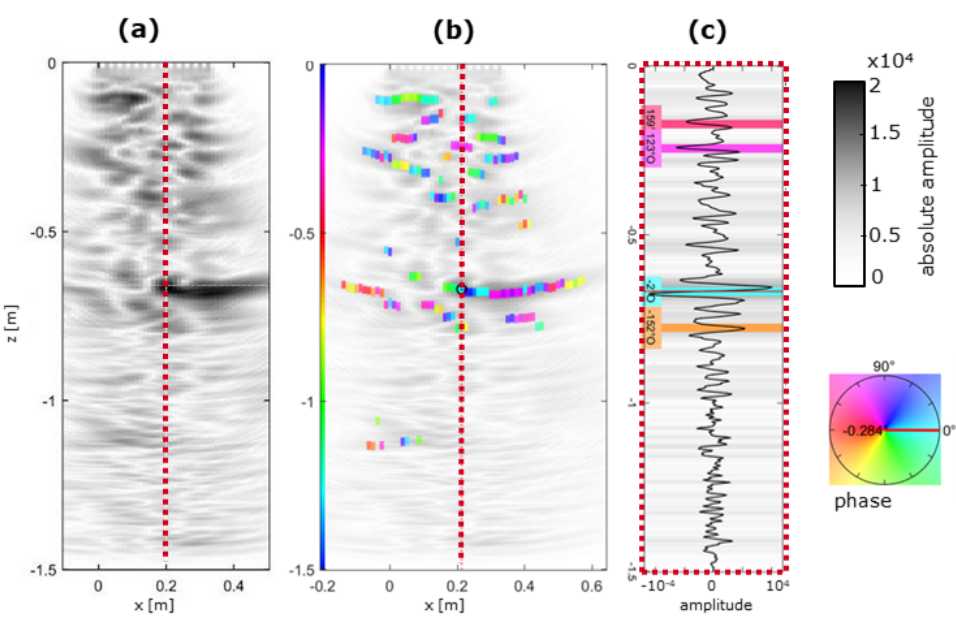
Figure 7. Phase analysis at GSBV3: ( a ) Ultrasonic image, as shown in Figure 6c, ( b ) overlain by phase analysis results; ( c ) individual analysed trace at central location (red dashed line) with determined phases of major